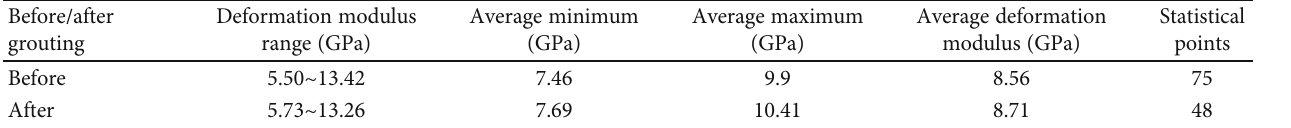
Figure 12: Velocity distribution before and after grouting for the #25 dam section. Table 9: Comparison of the deformation modulus before and after